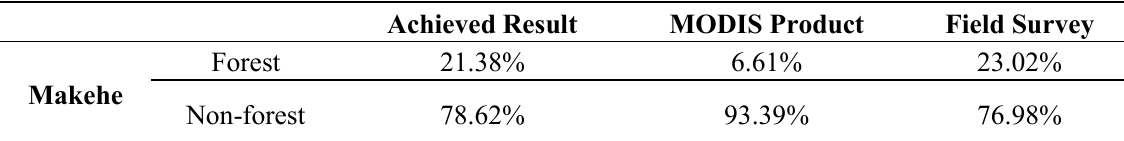
Table 4. Comparisons of vegetation coverage (in percent) among the hierarchical soft time-space classification result (achieved result), MODIS 2007 product and field survey records applied in Makehe Forest